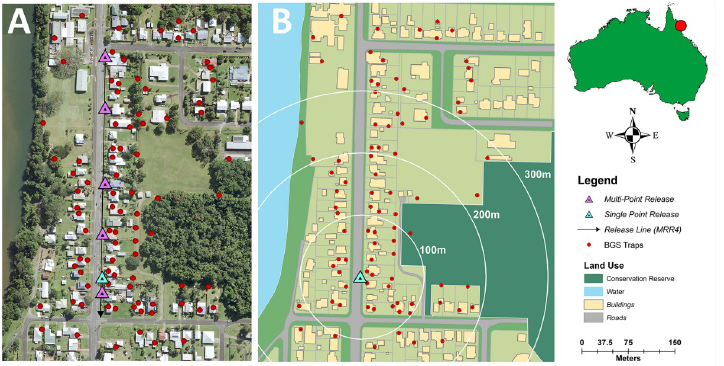
Fig 1. Location of study site in South Innisfail, Australia. Maps indicate landscape characteristics which include natural imagery (1A) and land use (1B). Rhodamine B marked Aedes aegypti were released at single point (blue triangle) and multi-point locations (purple triangles) and recaptured using Biogents Sentinel traps (red circles). Base layer imagery of South Innisfail (1A) provided by State of Queensland [2018] under licence [37] and landuse basemap (1B) digitized manually